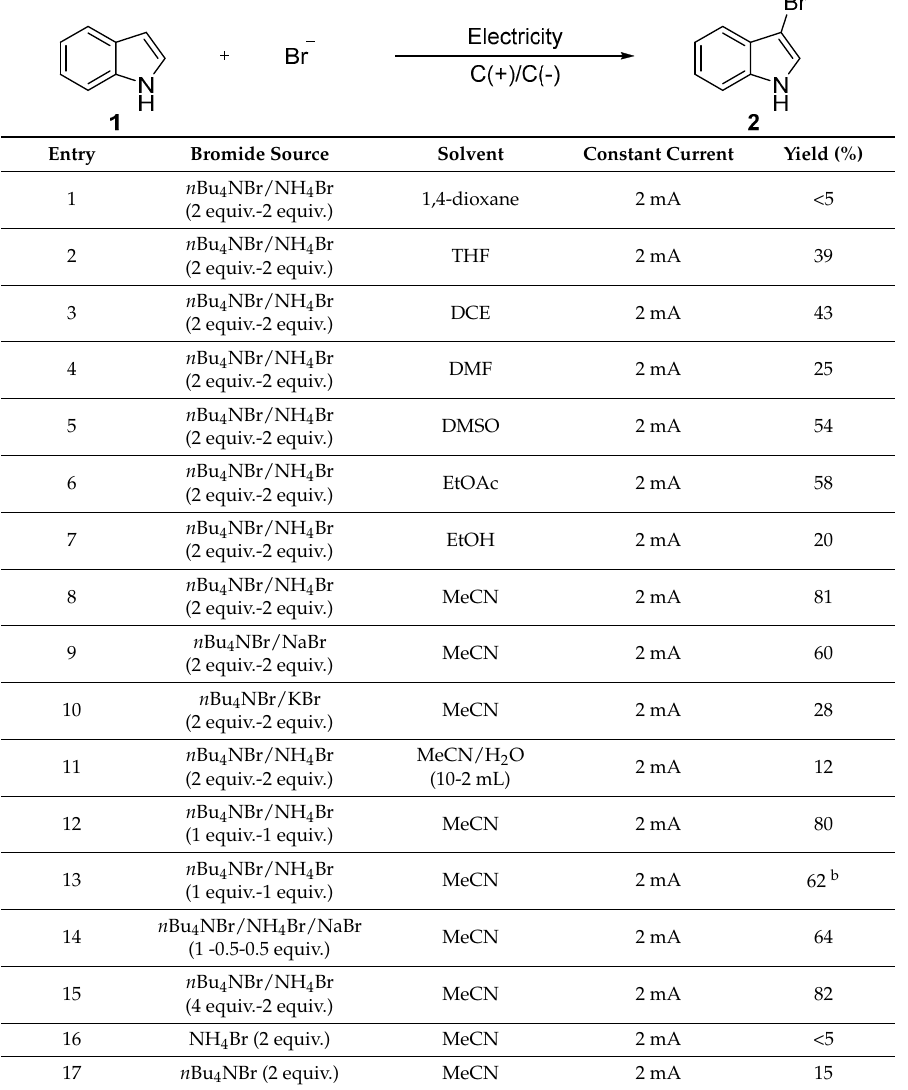
Table 1. Reaction optimization. a.